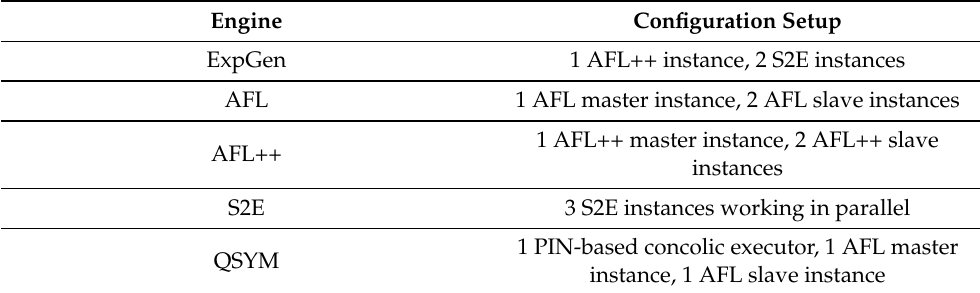
Table 3. Engine Configuration.